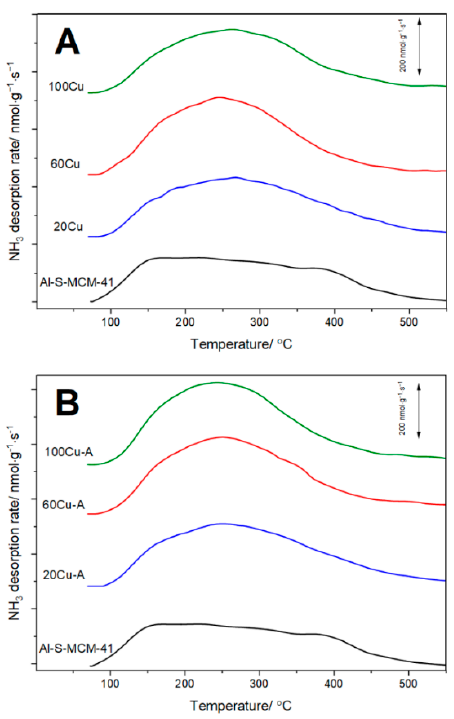
Figure 9. NH 3 -TPD profiles of the Al-S-MCM-41 sample modified with copper by TIE ( A ) and TIE-NH 3 ( B ) methods.